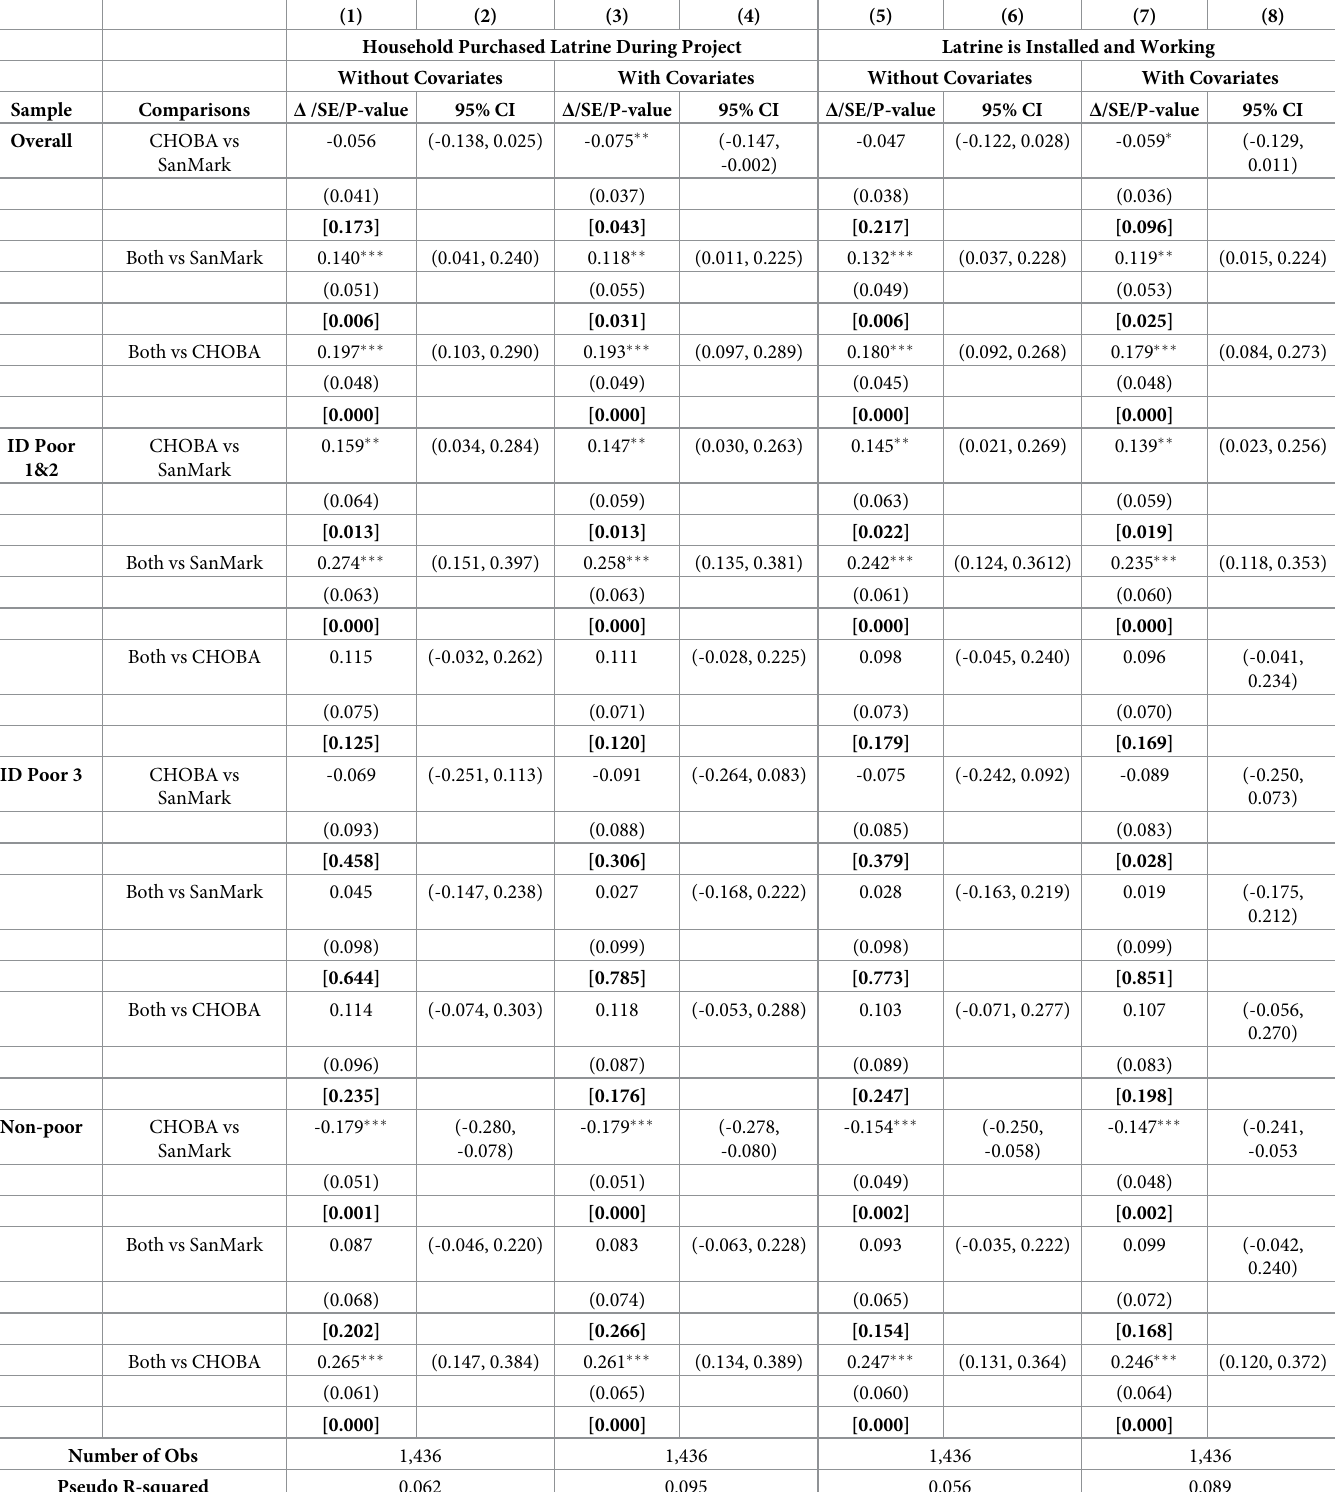
Table 5. Estimated marginal differences of outcomes between village programs by income